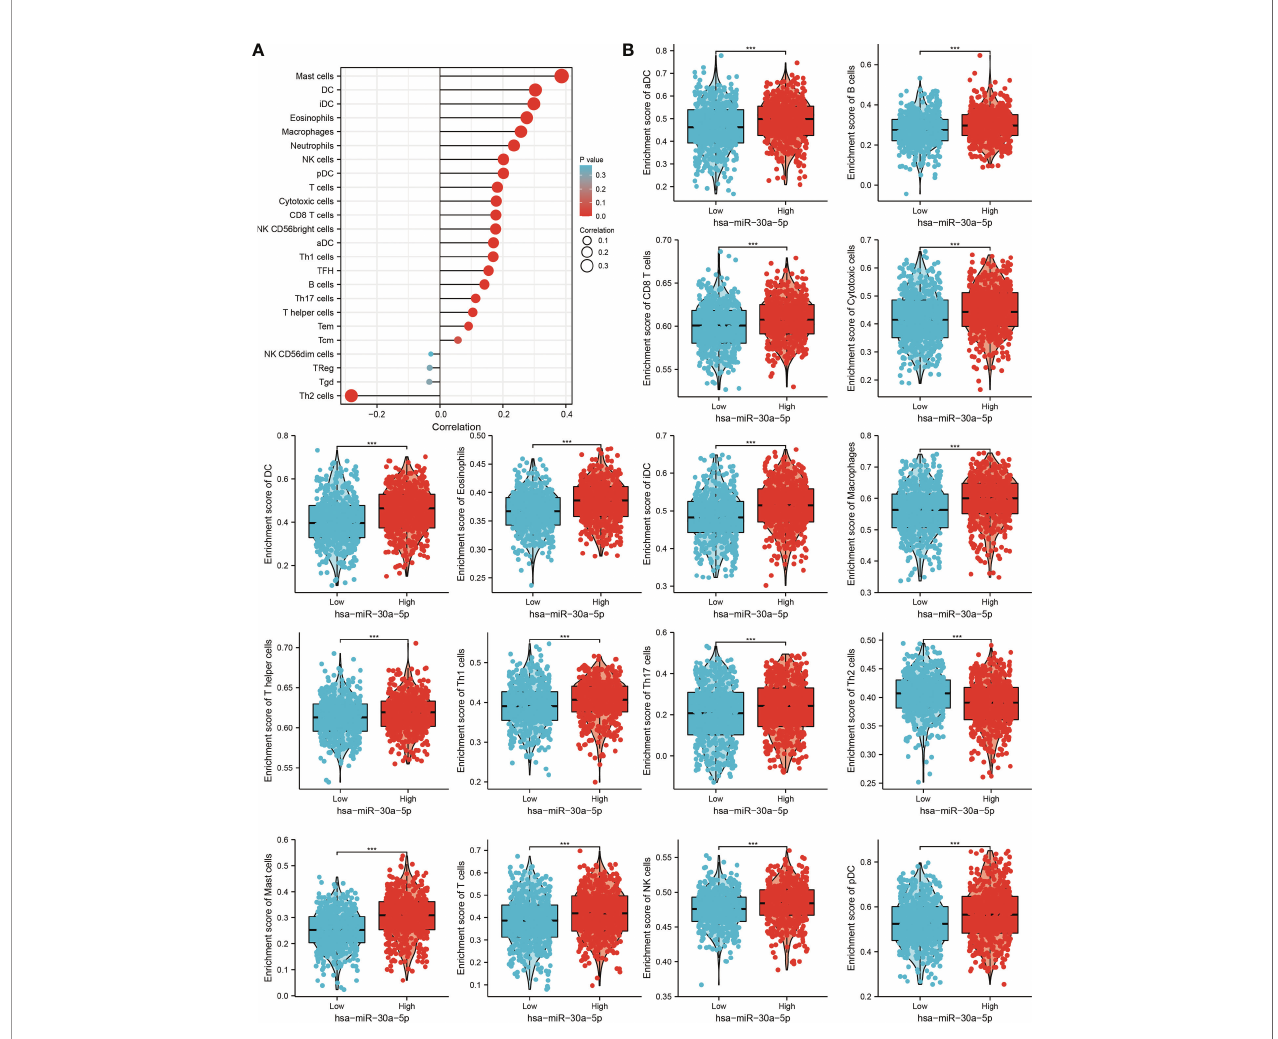
FIGURE 10 | Analysis of the correlation between miRNA-30a-5p expression and immune in fi ltration. (A) Correlation between the relative abundances of 24 immune cells and miRNA-30a-5p expression level. (B) Diverse proportions of immune cell subtype in tumor samples in high and low miRNA-30a-5p expression